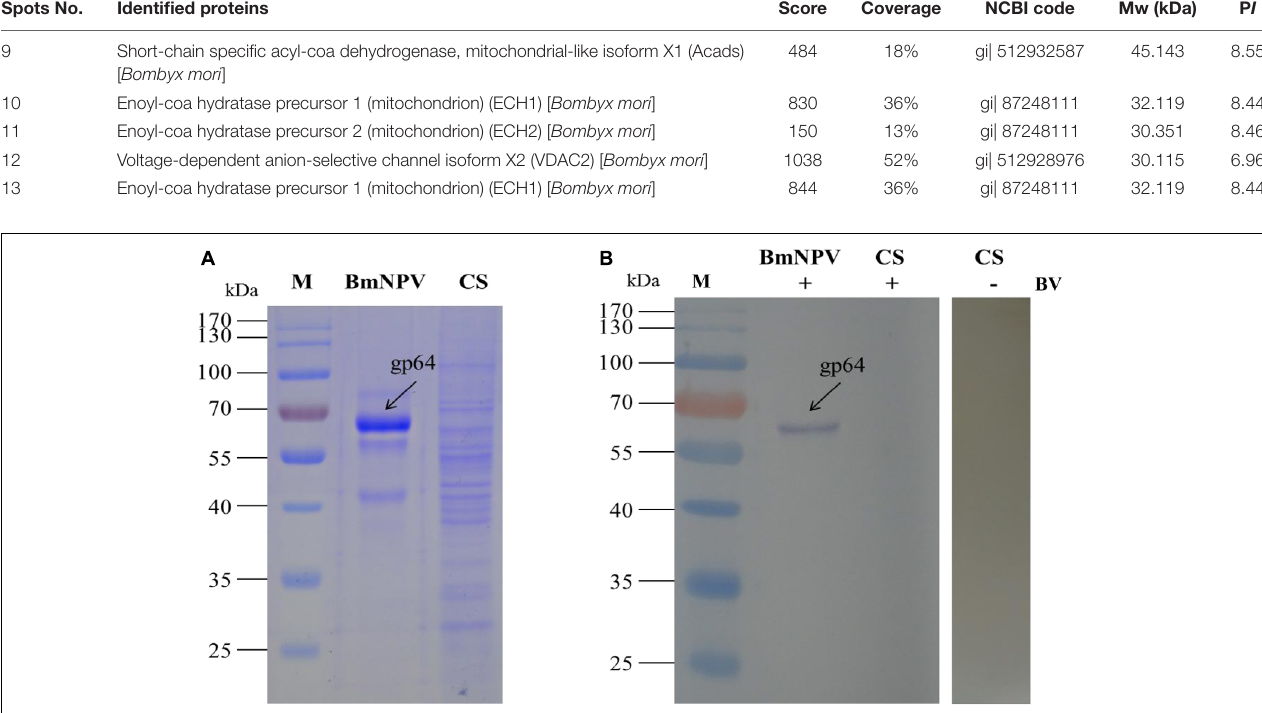
TABLE 4 | Identification of BmNPV-binding proteins from B. mori midgut microsomes separated by 2-DE and identified by MALDI-TOF/TOF MS. Spots No.